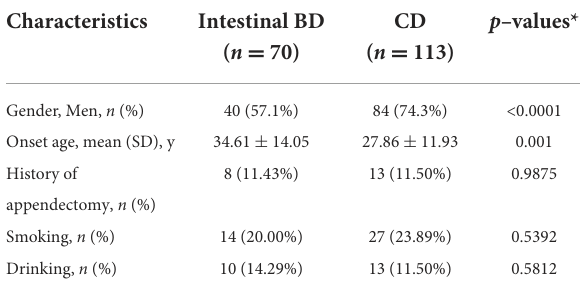
TABLE 2 Demographic characteristics of participants with CD or intestinal